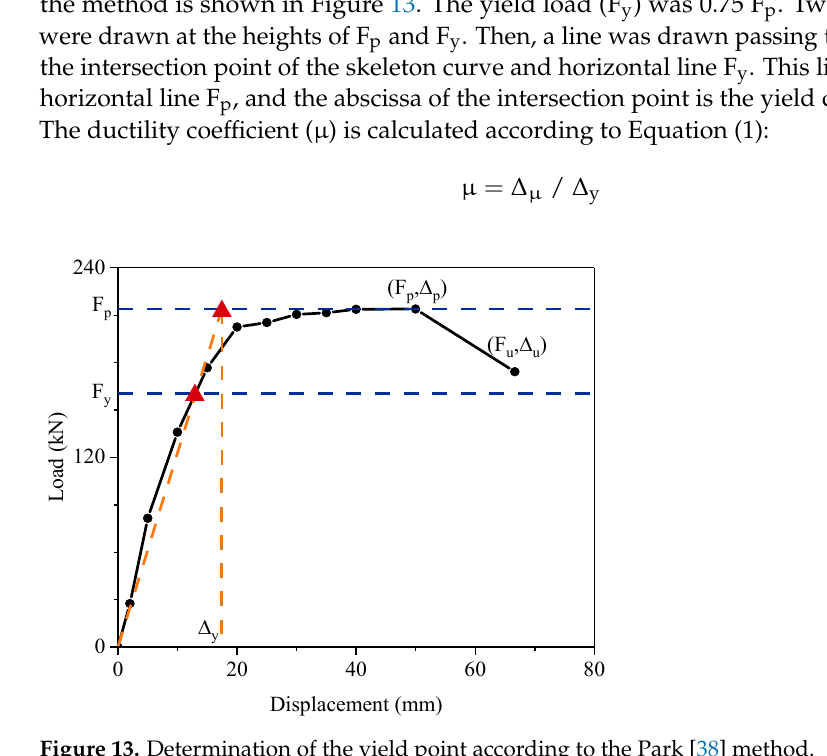
Figure 13. Determination of the yield point according to the Park [38] method. Table 4. Seismic performance characteristics for the specimens.